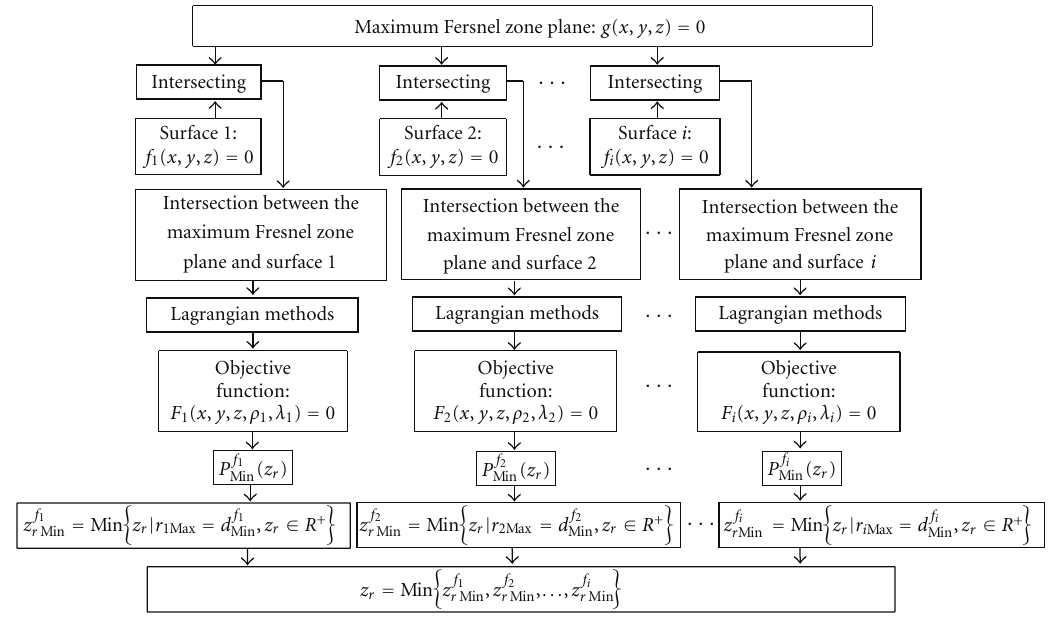
Figure 1: Flow chart of modeling for the diving point in arbitrary cross-sectional